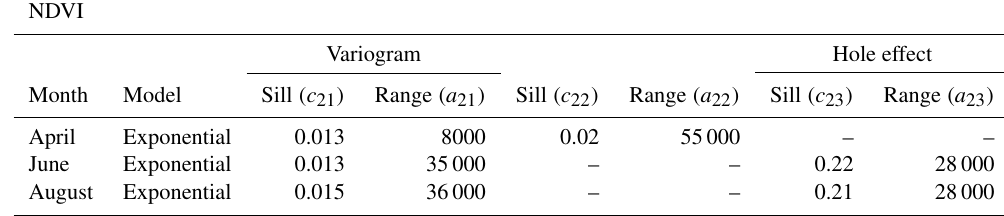
Table 2. Random function model parameters of NDVI semivariograms.